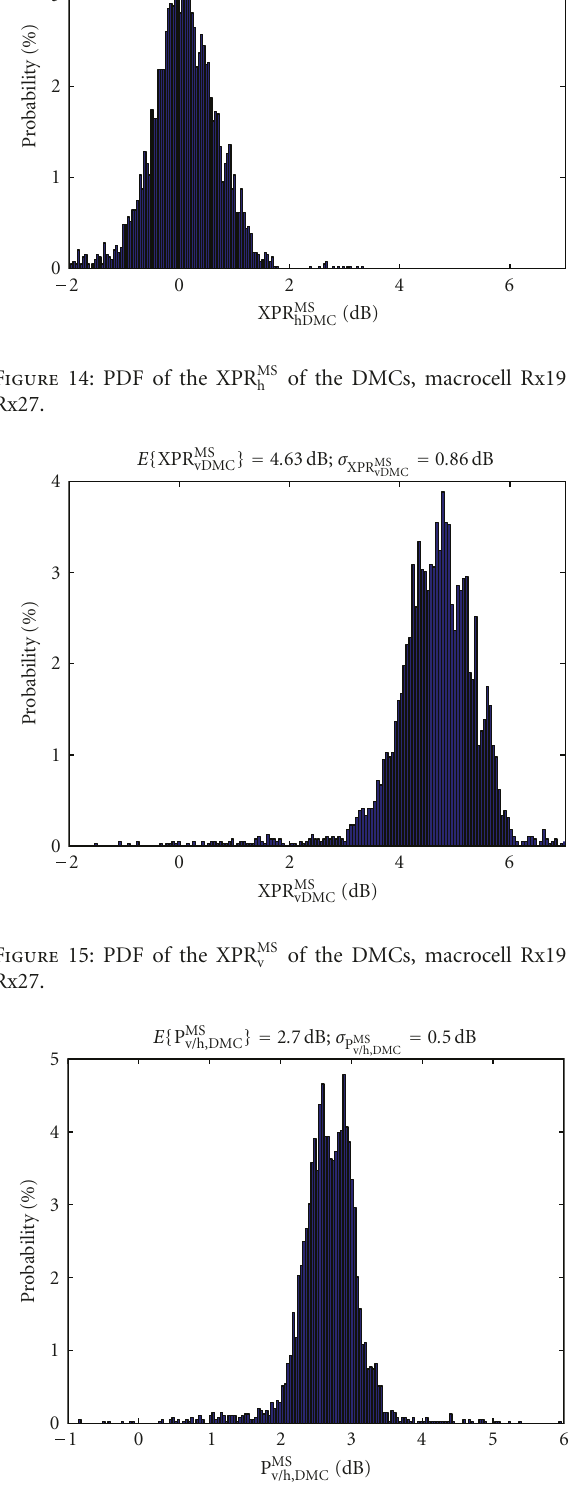
Figure 16: PDF of the P MS